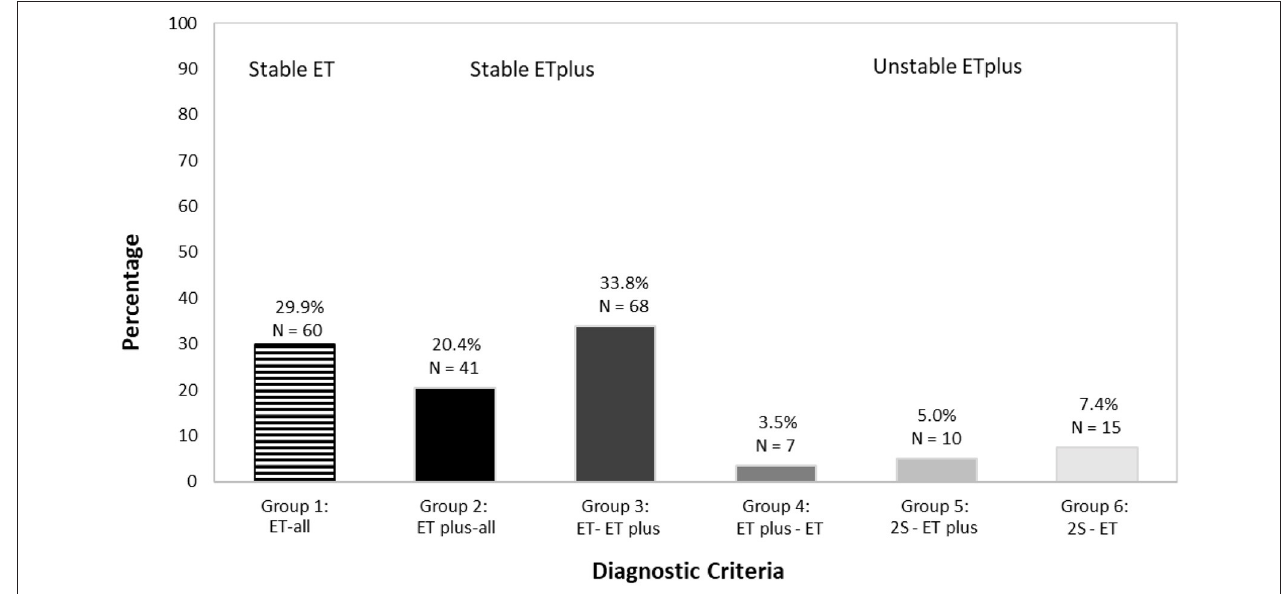
FIGURE 7 | Secondary analysis of distribution of types of ET vs. ET plus in 201